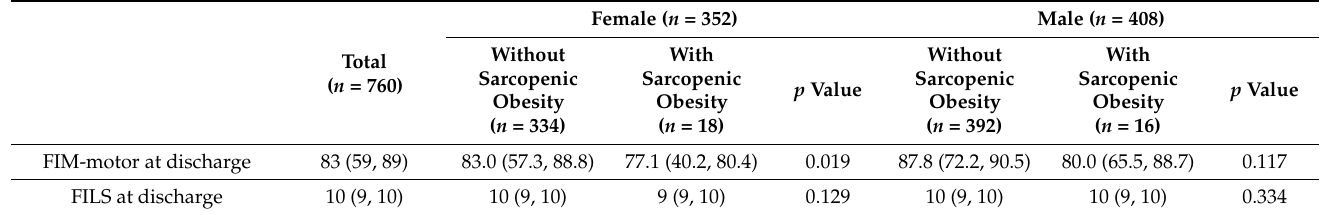
Table 3. Univariate analyses for outcomes between patients with and without sarcopenic obesity defined by ESPEN and EASO criteria 2022.